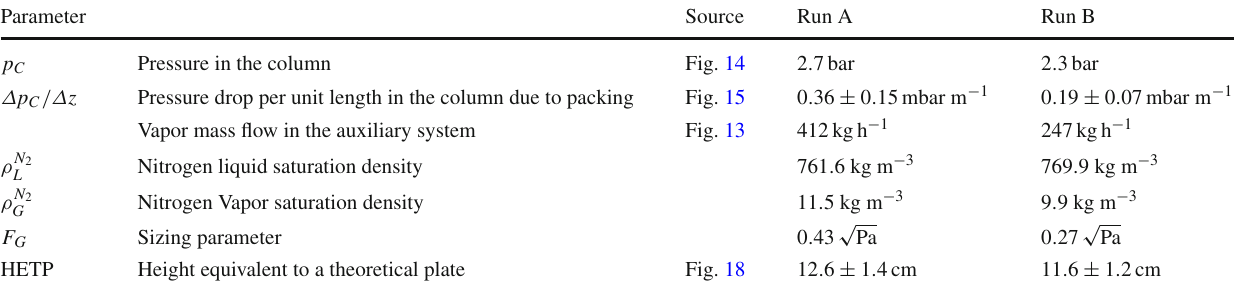
Table 1 Measured and calculated parameters for Run A and Run B, with the prototype column. All quantities below are average values over the respective runs Parameter Source Run A Run B p C Pressure in the column Fig. 14 2 . 7bar 2 . 3bar /Δ z Pressure drop per unit length in the column due to packing Fig. 15 0 . 36 ± 0 . 15mbar m − 1 0 . 19 ± 0 . 07mbar m − 1 Δ p C Vapor mass flow in the auxiliary system Fig. 13 412kgh − 1 247kgh − 1 ρ N 2 Nitrogen liquid saturation density 761 . 6 kg m − 3 769 . 9 kg m − 3 L ρ N 2 Nitrogen Vapor saturation density G Sizing parameter HETP Height equivalent to a theoretical plate Fig.